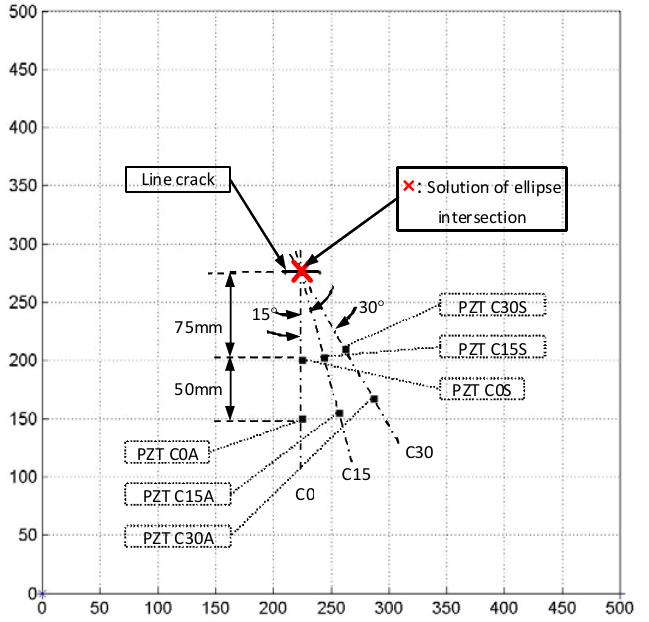
Figure 8. Determination of crack orientation (adopted from Figure 7 in